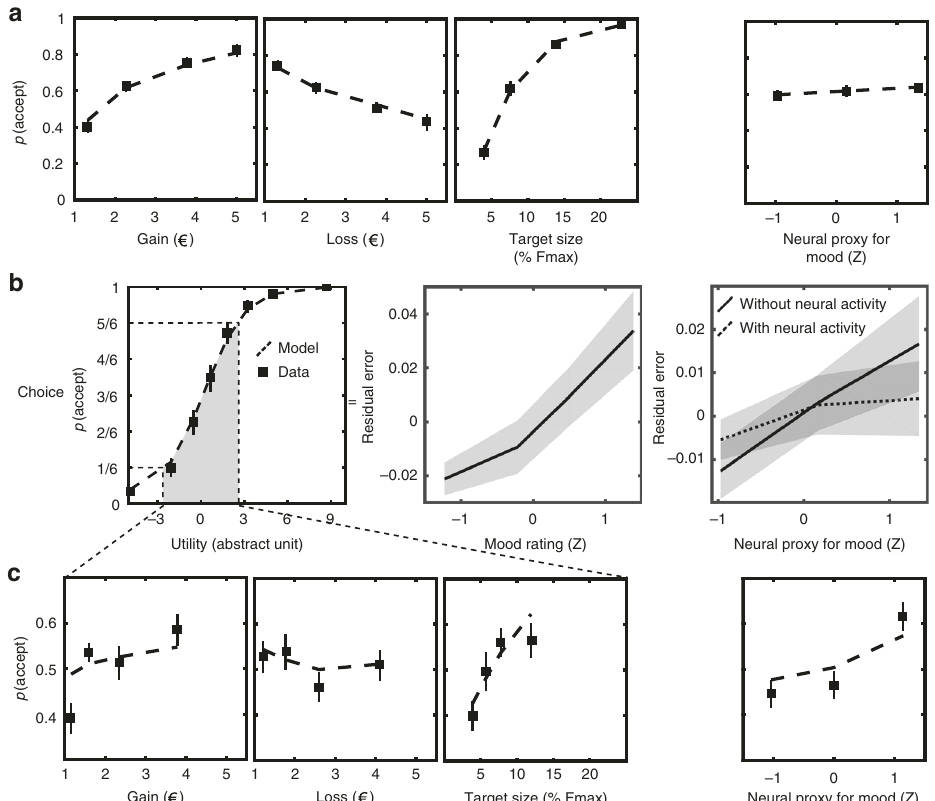
Fig. 3 Choice behavior. The different panels show the effects of experimental factors and neural activity on the probability to accept the motor challenge (in experiment 3, unless indicated otherwise). a Acceptance probability as a function of the prospect dimensions (gain, loss, target size) and the neural proxy for mood (NPM). Squares are binned data points. Dashed line represents acceptance probability as computed by the best choice model. b Left panel: acceptance probability as a function of expected utility. Dashed line represents acceptance probability as computed in the best choice model (without modulation of free parameters by neural activity). Middle panel (experiment 2): Residual error of choice (actual choice – acceptance probability) as a function of mood rating. Right panel: Residual error of choice (actual choice – acceptance probability) as a function of NPM for the best choice model with (dashed line) and without (solid line) modulations of k g by vmPFC baseline and k l by aIns baseline. Note that these modulations captured most of the in fl uence of NPM on the variance in choices that was not explained by task factors. c Acceptance probability as a function of prospect dimensions and NPM, but restricted to trials for which acceptance probability (as computed by the best choice model without modulation of free parameters by neural activity) was between 1/6 and 5/6. Here the effect of baseline activity in mood-related regions was of a similar size as the effects of task factors. Error bars represent inter-subject s.e.m.